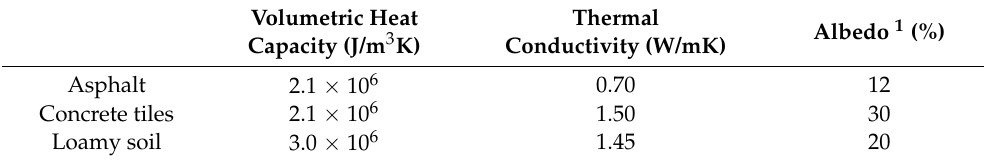
Table 4. Thermal and optical properties of the ground surface materials [24,25].